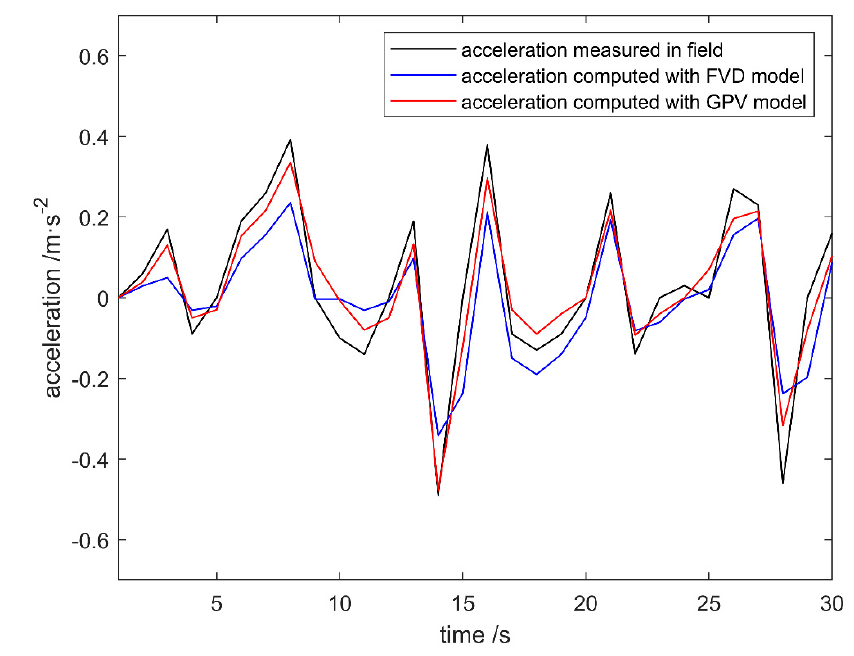
Figure 3. Comparison of computational acceleration between the GPV model and the FVD model with the verification data sets (part).